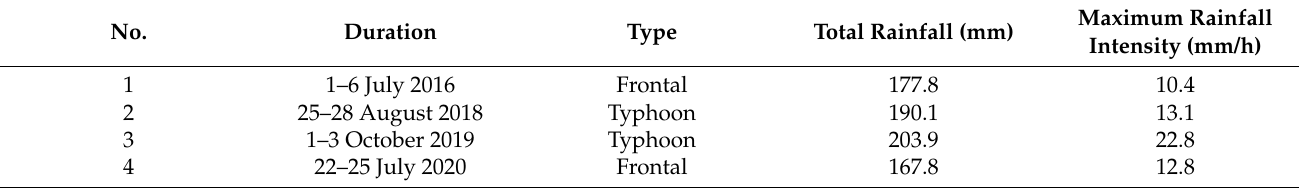
Figure 2. Time series plots of mean rain rate observed at 10 rain gauge stations located within the Beaslesan radar umbrella during ( a ) 1–6 July 2016, ( b ) 25–28 August 2018, ( c ) 1–3 October 2019, and ( d ) 22–25 July 2020. Table 3. Basic characteristics of the four storm events used in this study.